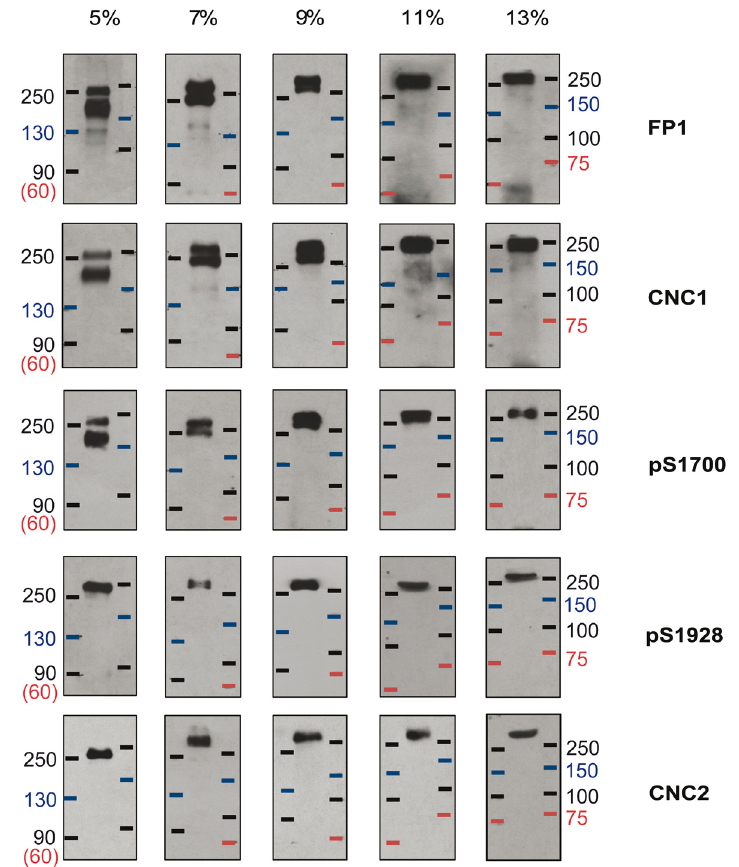
Figure 3. Analysis of α 1.2 size forms by SDS-PAGE with increasing acrylamide concentrations. Ca 1 mouse brain extracts (Triton X-100) with the FP1 antibody against α 11, and 13% acrylamide followed by immunoblotting with the indicated antibodies. Two different prestained marker protein sets were used to estimate M R